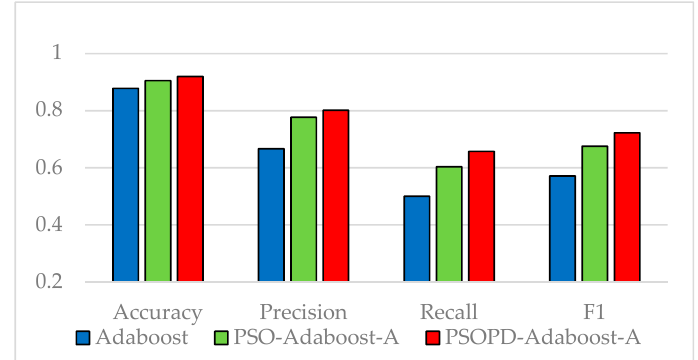
Figure 10. Performance Comparison of the AdaBoost, PSO-AdaBoost-A, and PSOPD-AdaBoost-A on Ionosphere Dataset.